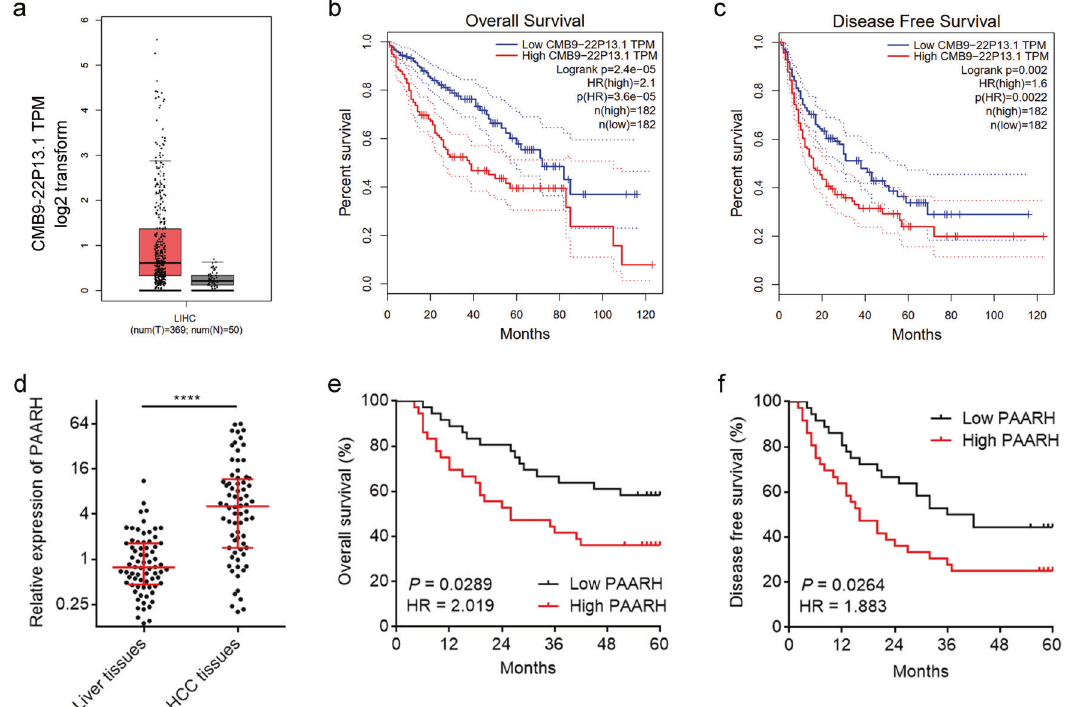
Fig. 1 PAARH was highly expressed and correlated with poor survival in HCC. a PAARH (CMB9-22P13.1) expression in 369 HCC tissues and 50 liver tissues according to TCGA LIHC dataset, analyzed by GEPIA. b The correlation between PAARH (CMB9-22P13.1) expression and overall survival according to TCGA LIHC dataset, analyzed by GEPIA. c The correlation between PAARH (CMB9-22P13.1) expression and disease-free survival according to TCGA LIHC dataset, analyzed by GEPIA. d PAARH expression in 72 pairs of HCC tissues and adjacent noncancerous liver tissues was measured by qRT-PCR. **** p < 0.0001 by Wilcoxon matched-pairs signed rank test. e Kaplan – Meier survival analysis of the correlation between PAARH expression and overall survival in our HCC cohort. n = 72, p = 0.0289, HR = 2.019 by log-rank test. f Kaplan – Meier survival analysis of the correlation between PAARH expression and disease-free survival in our HCC cohort. n = 72, p = 0.0264, HR = 1.883 by log-rank